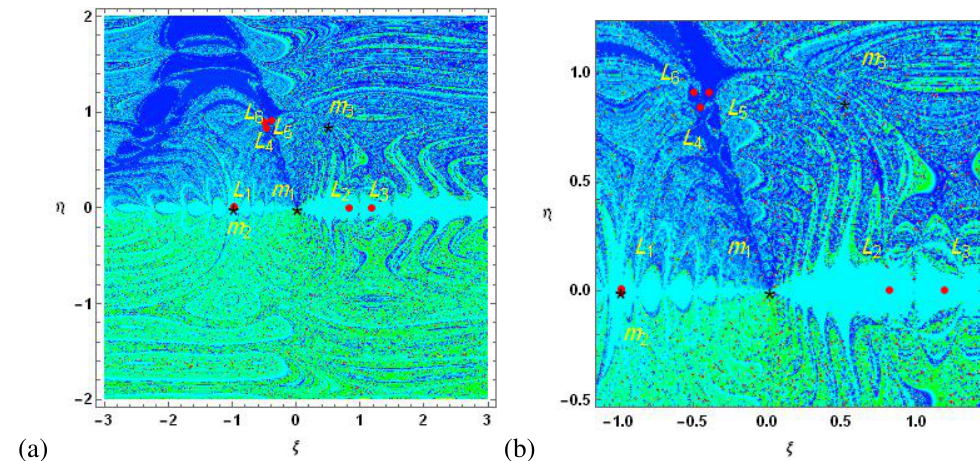
Fig. 6 (a): The basin of attraction for the case when third primary is placed at one of the lagrangian points of the classical circular restricted three- body problem. (b): Zoomed image of (a) near the lagrangian configuration.